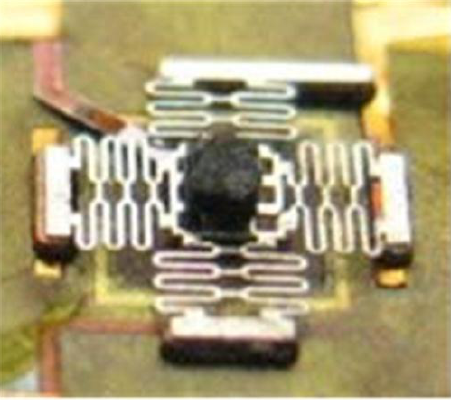
Figure 11. The prototype of the microswitch.